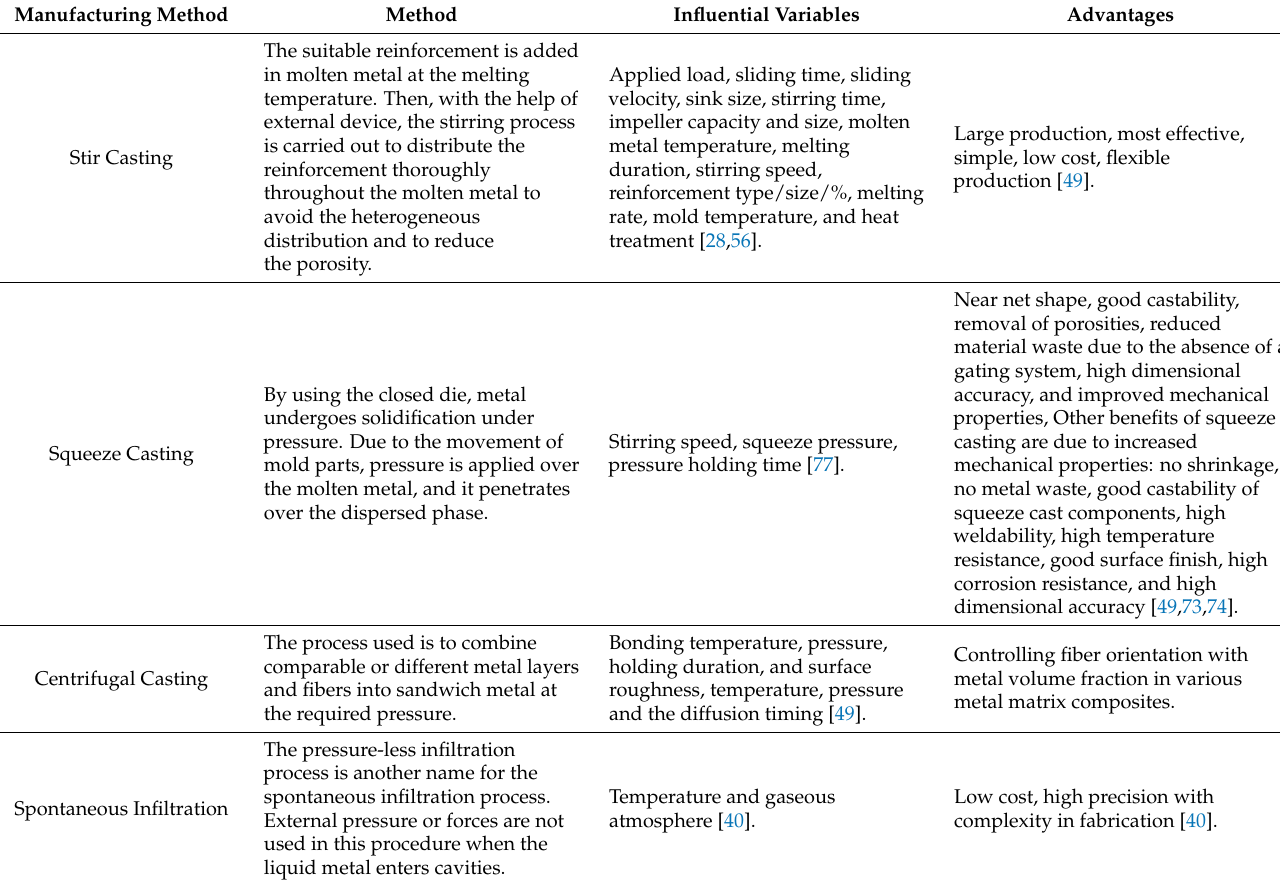
Table 6. The summary of liquid-state